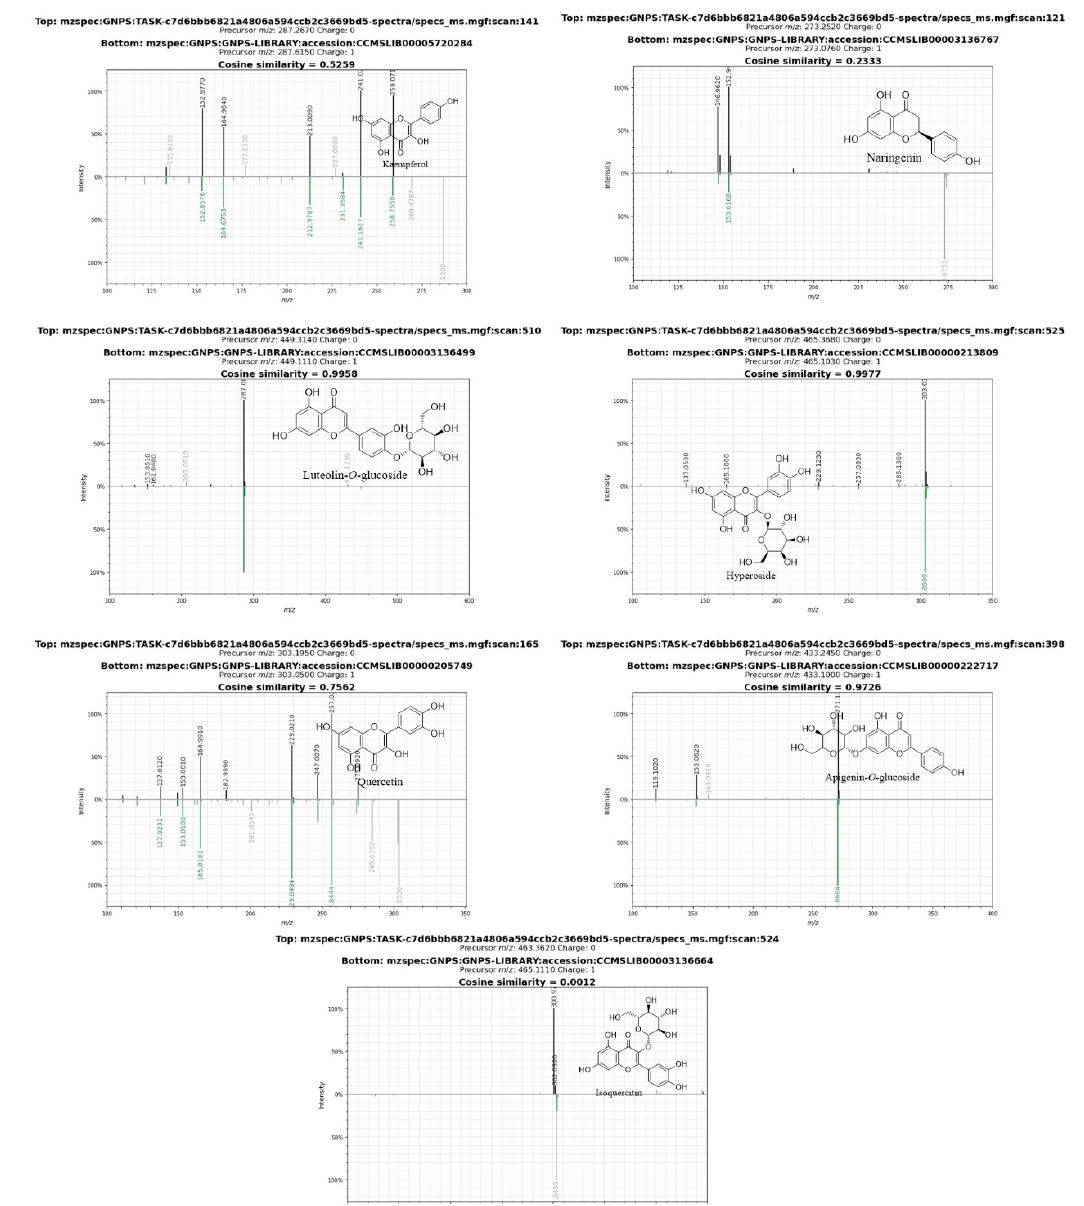
Figure 2. Mirror image of identified compounds from methanolic extract of A. hierochuntica compared to spectra of GNPS library. Table 2. Compounds (L1-L14) identified from A. hierochuntica.